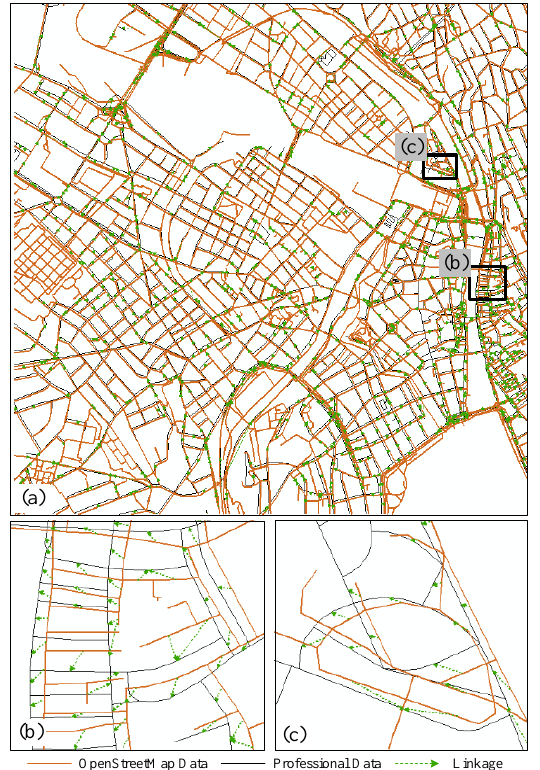
Figure 7 Matching results in Zurich (about 9 km 2